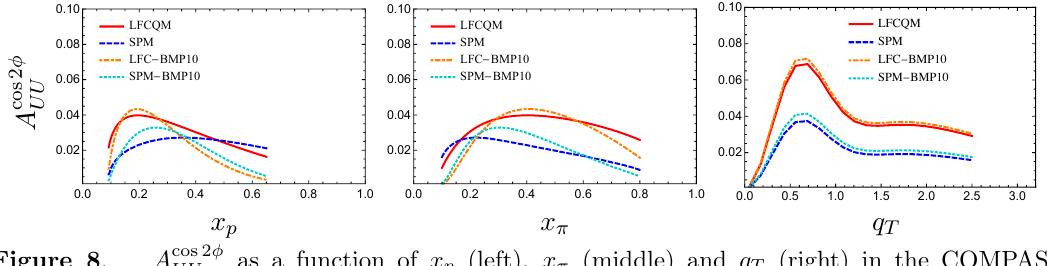
Figure 8 . A cos2 (cid:30) kinematics.